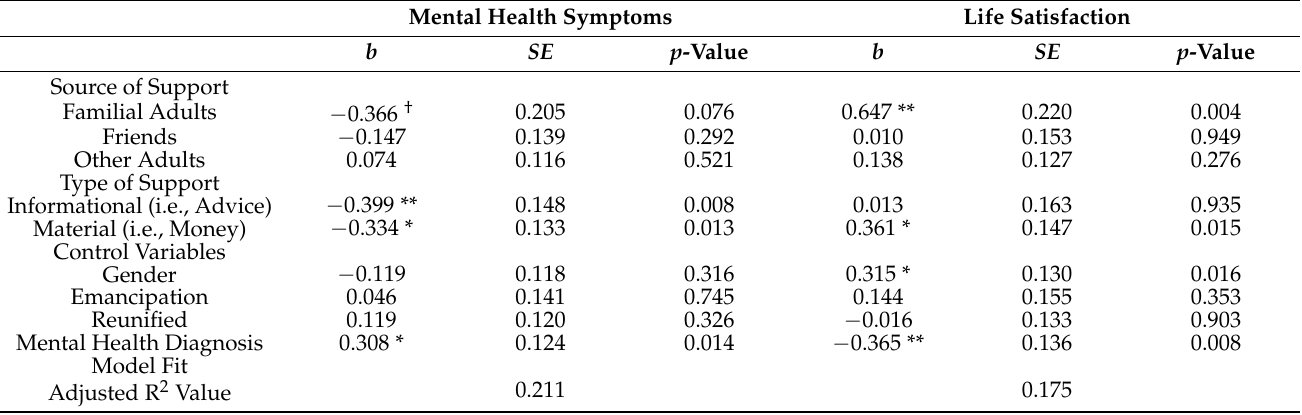
Table 2. Linear Multiple Regression Analysis of Mental Health Symptoms and Life